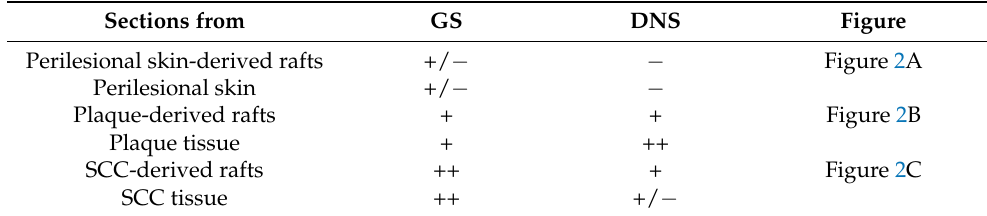
Table 2. RNA in situ hybridization (RISH) analysis of EcPV2 E6/E7 mRNA in raft and tissue sections. Sections